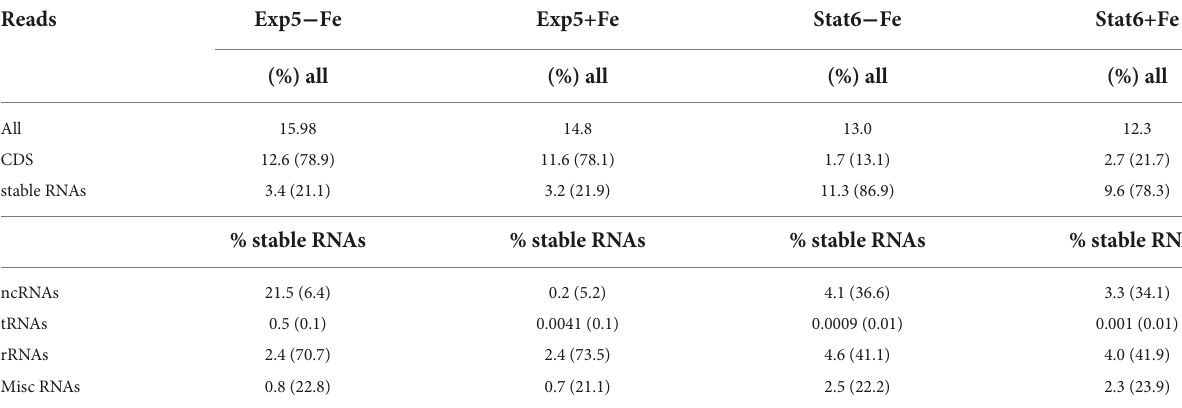
TABLE 2 General description of the transcriptomic results.